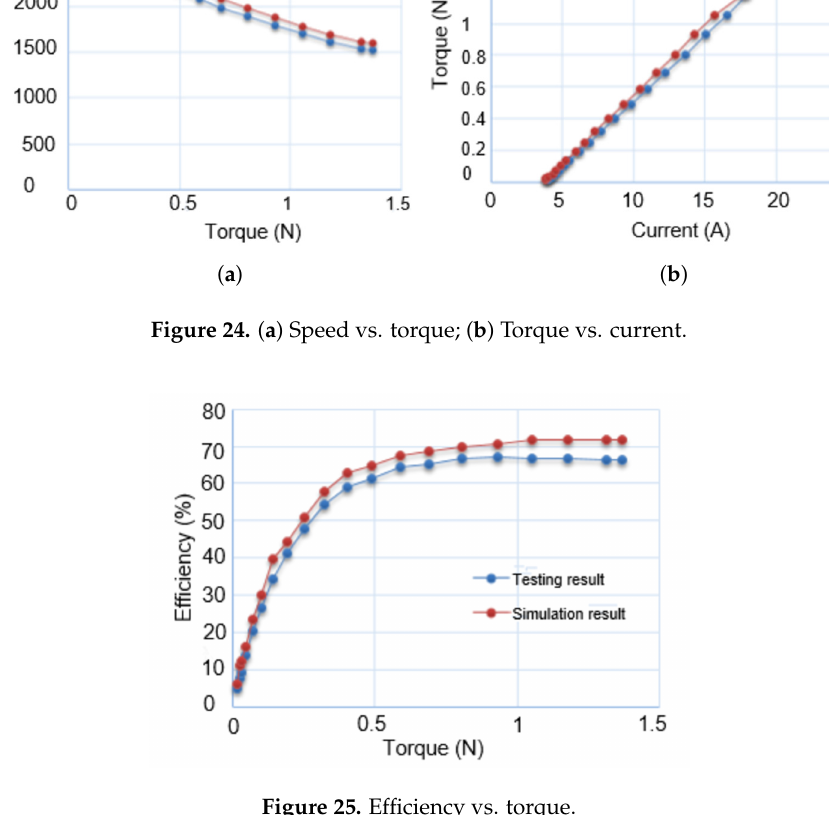
Figure 25. Efficiency vs.